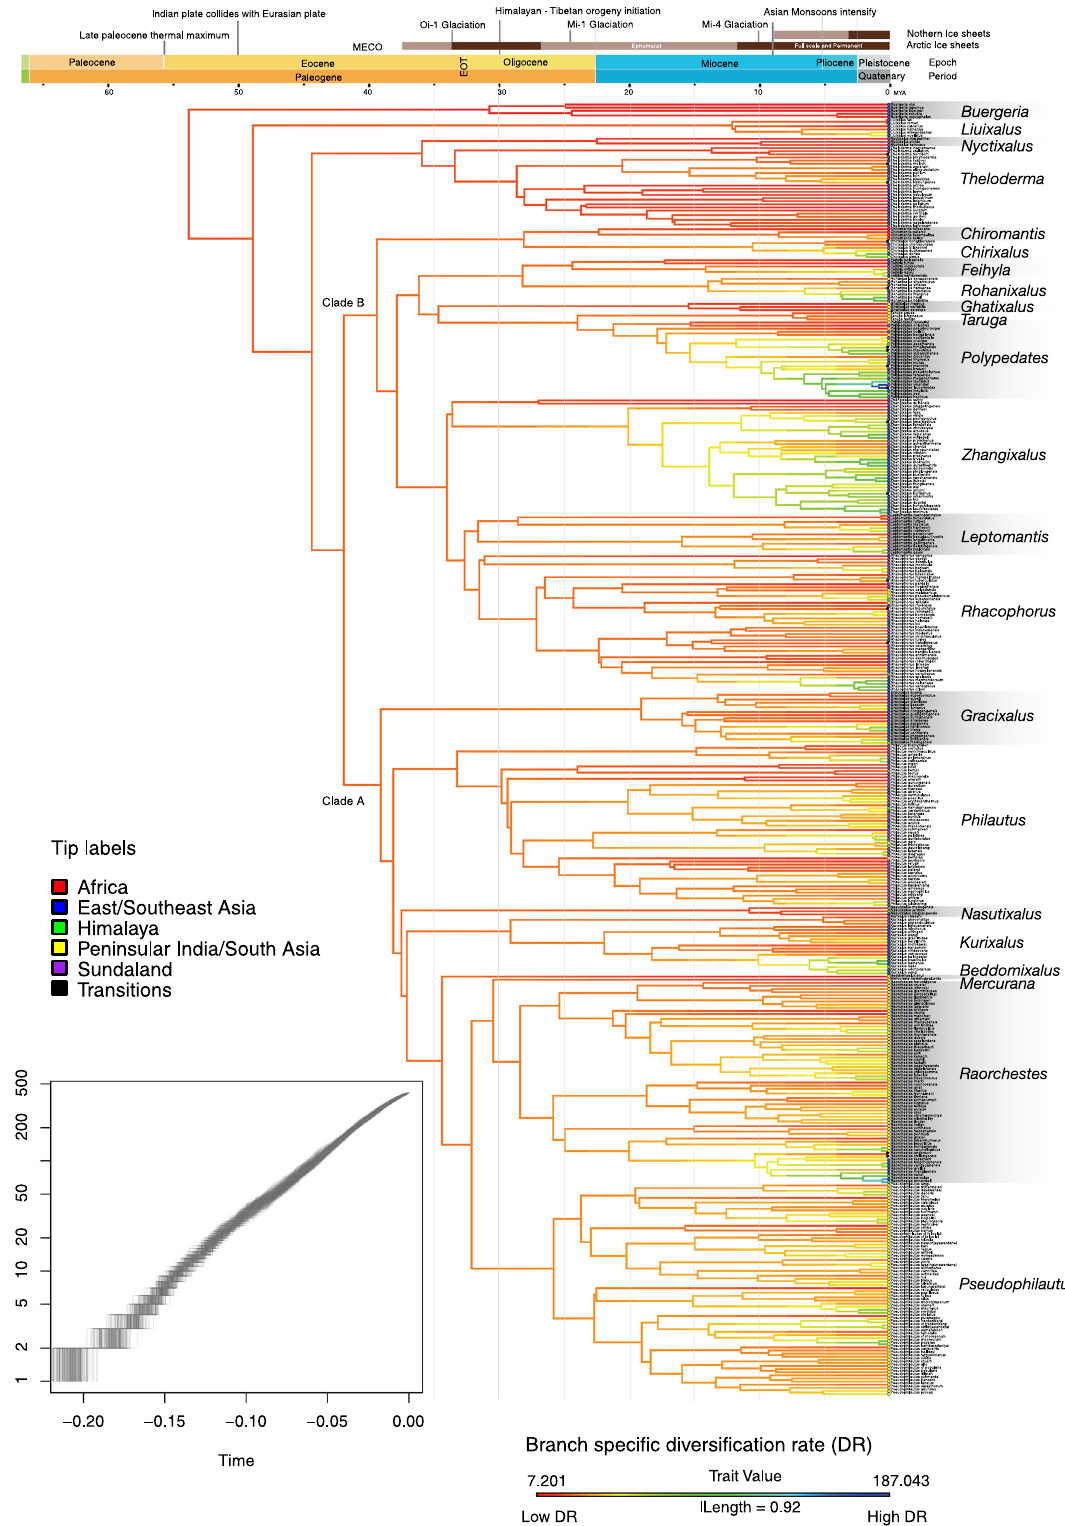
Fig. 1 Complete phylogeny of rhacophorid frogs, with diversi fi cation rates (DR) traced across branches. The phylogeny is based on 58 AHE 18 and 315 Sanger sequence data for 415 species. Genetic data were unavailable for 94 species, whose positions in the phylogeny are inferred (constrained) by assessing other taxonomic information. The lineage-through-time plot (LTT;sub-plot) shows a constant rate of diversi fi cation, but rates traced on the phylogeny show localized variation, especially among clades (genera): younger taxa have faster diversi fi cation rates (cool colors) than older, basal taxa (warmer colors). Colored dots at branch tips indicate the geographic region in which each species occurs; “ Transitions ” denotes species occurring in two or more